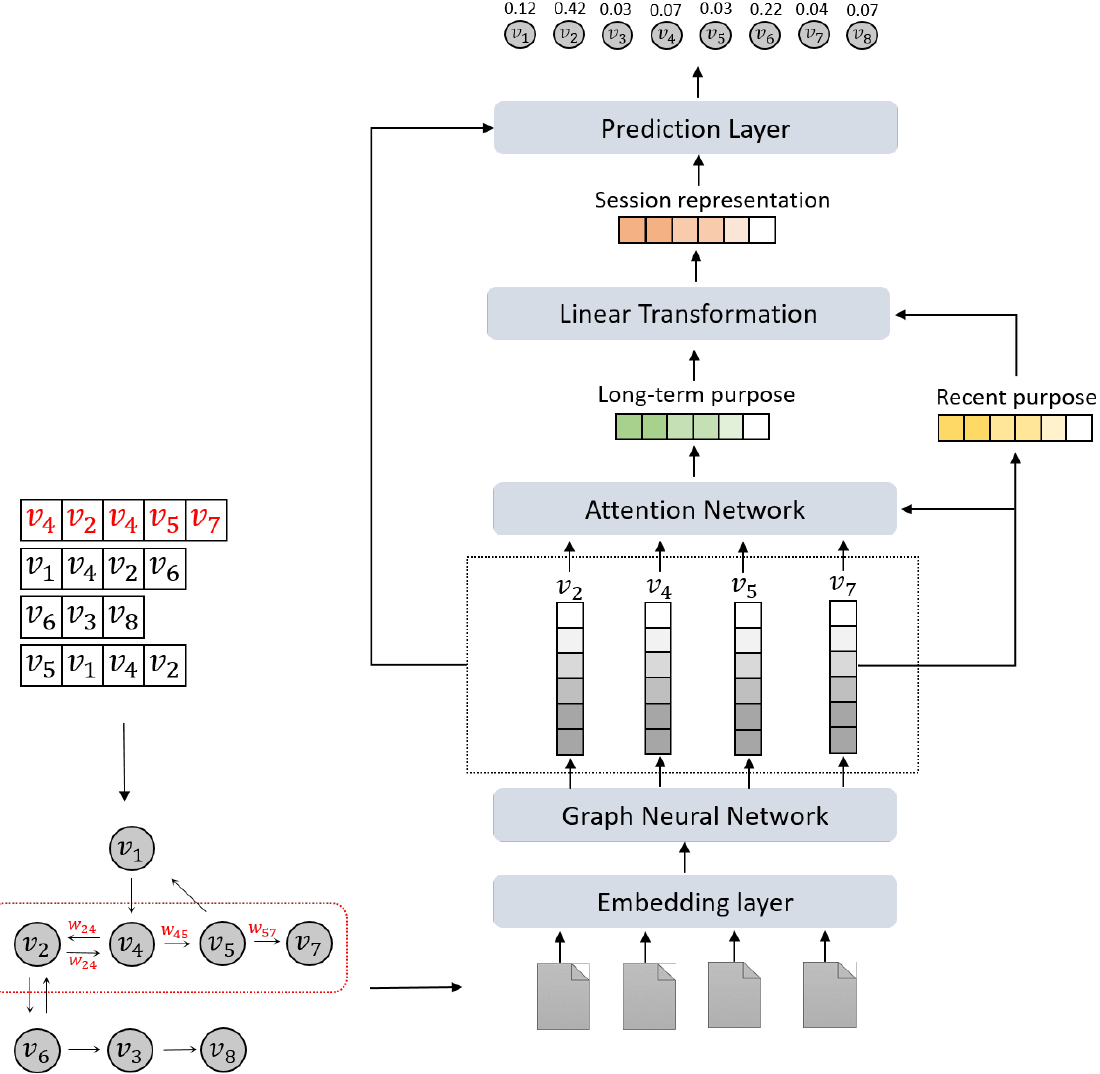
Figure 1. The framework of the proposed TXT-SR